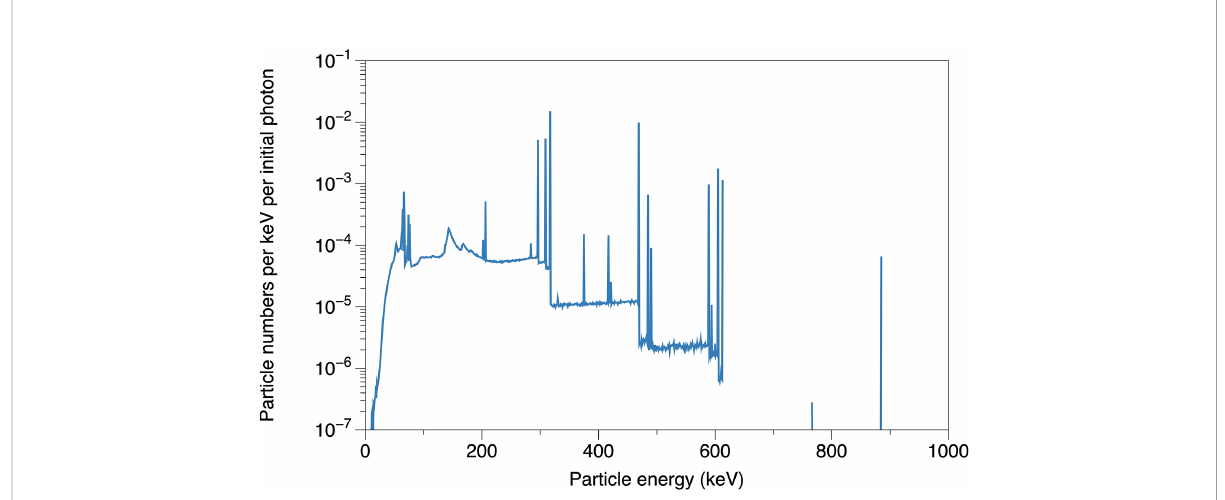
FIGURE 3 The simulated particle energy spectrum emitted from brachytherapy source model, recorded on parallel plane at 2 cm distance from source